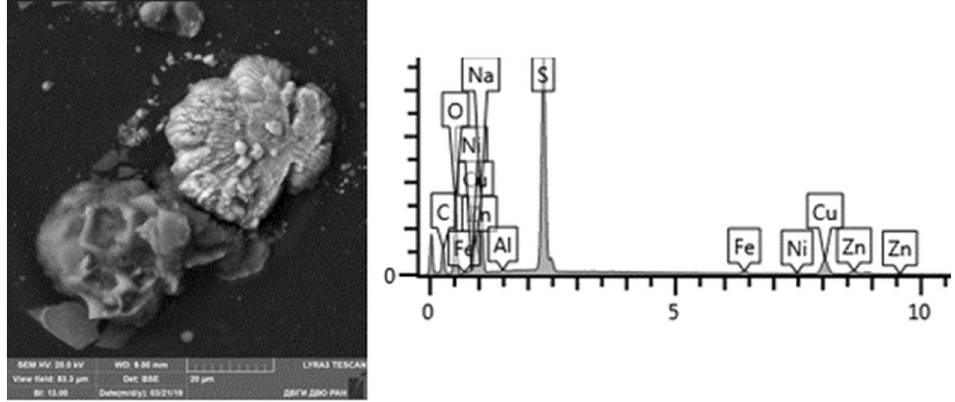
Figure 12. Desmutting. Particles morphology. Scanning electronic microscopy. Measuring interval 20 µm.